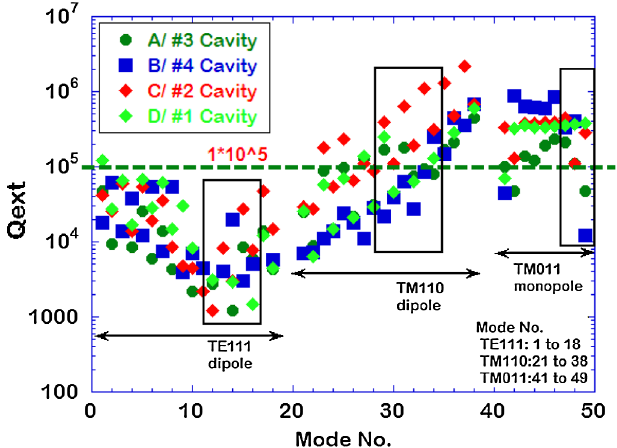
FIG. 15. (Color) External Q values ( Q in four Tesla-like cavities. The Q HOM-1 and HOM-2 couplers located on both sides of the cavity. The black squares show that the dangerous higher order modes with high impedance have strong coupling with a beam.